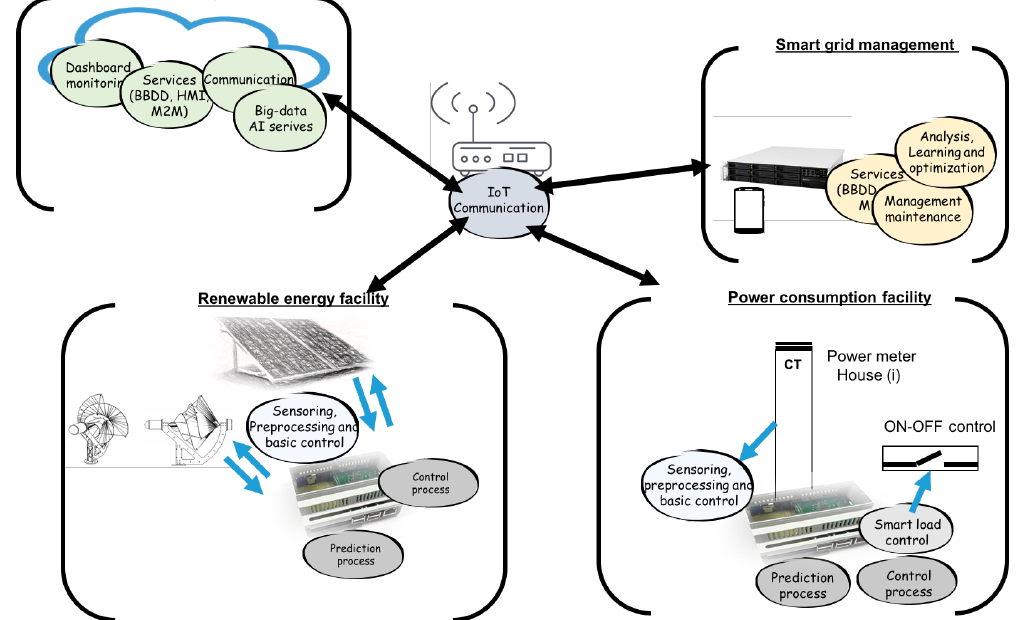
Figure 10. Subsystems in the data flow analysis: power consumption, renewable energy, smart grid management, cloud subsystems, and IoT